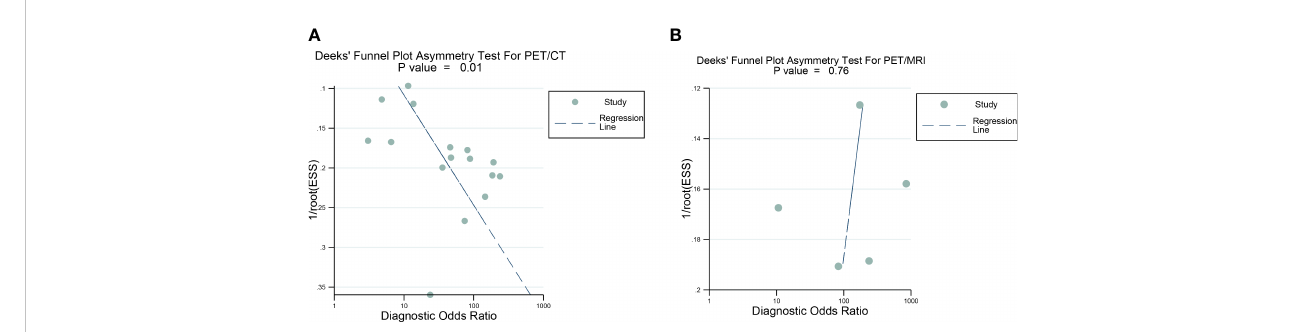
FIGURE 8 Deek ’ s funnel plot was used to evaluate the publication bias of [18F]FDG PET/CT and [18F]FDG PET/MRI. (A) Deek's funnel plot for PET/CT; (B) Deek's funnel plot for PET/CT. P<0.05 was considered signi fi cant.